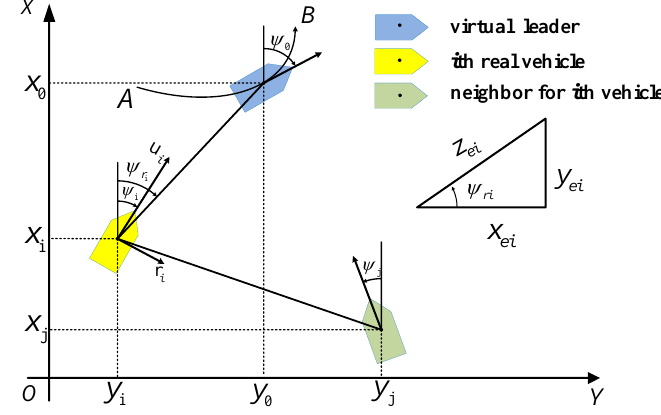
Figure 2. The schematic diagram of the proposed control principle .